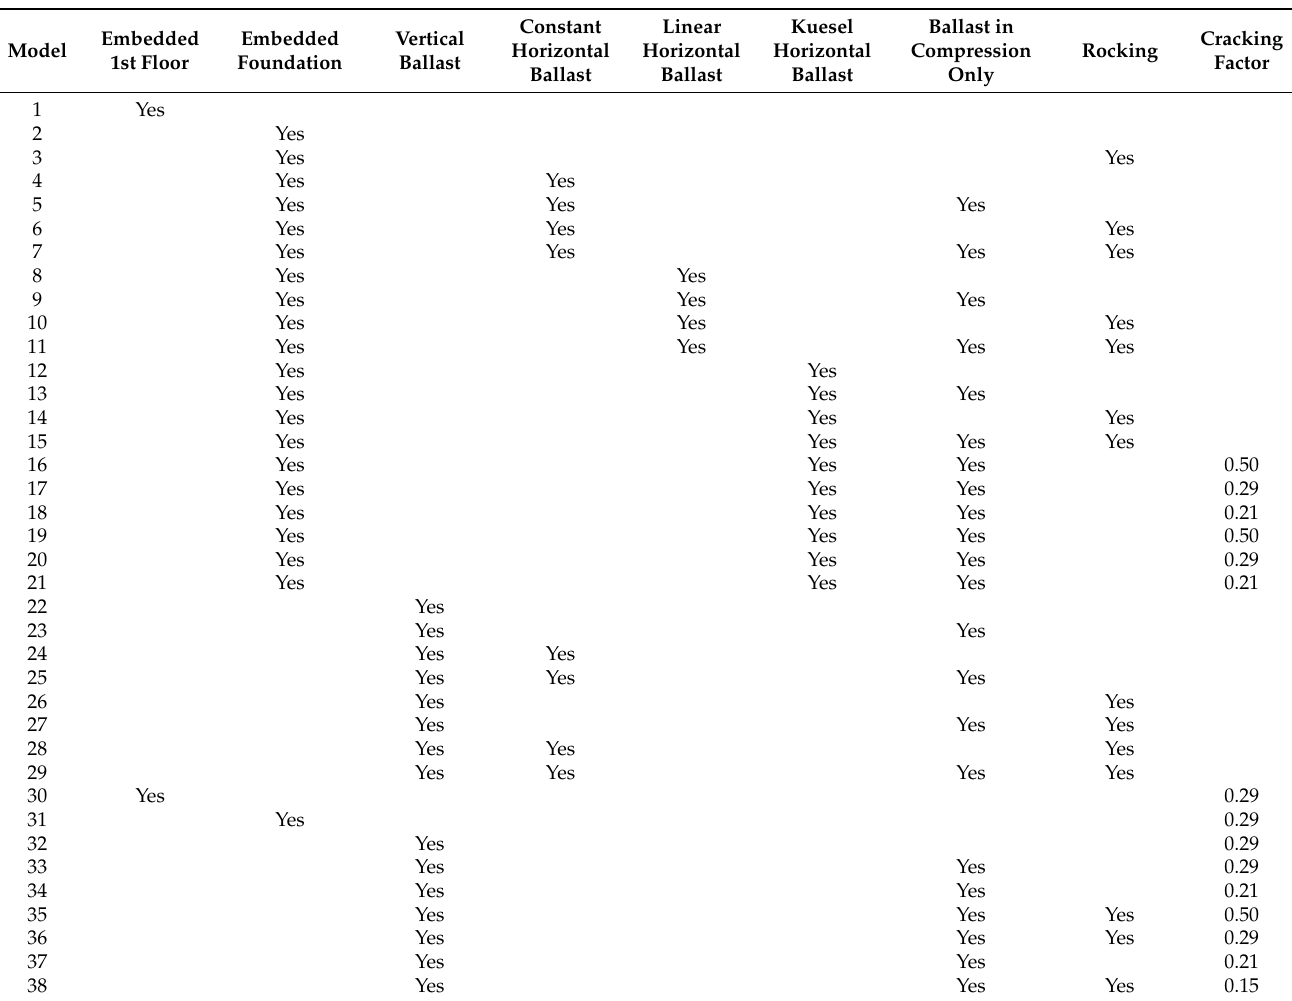
Table 1. Models analyzed in this